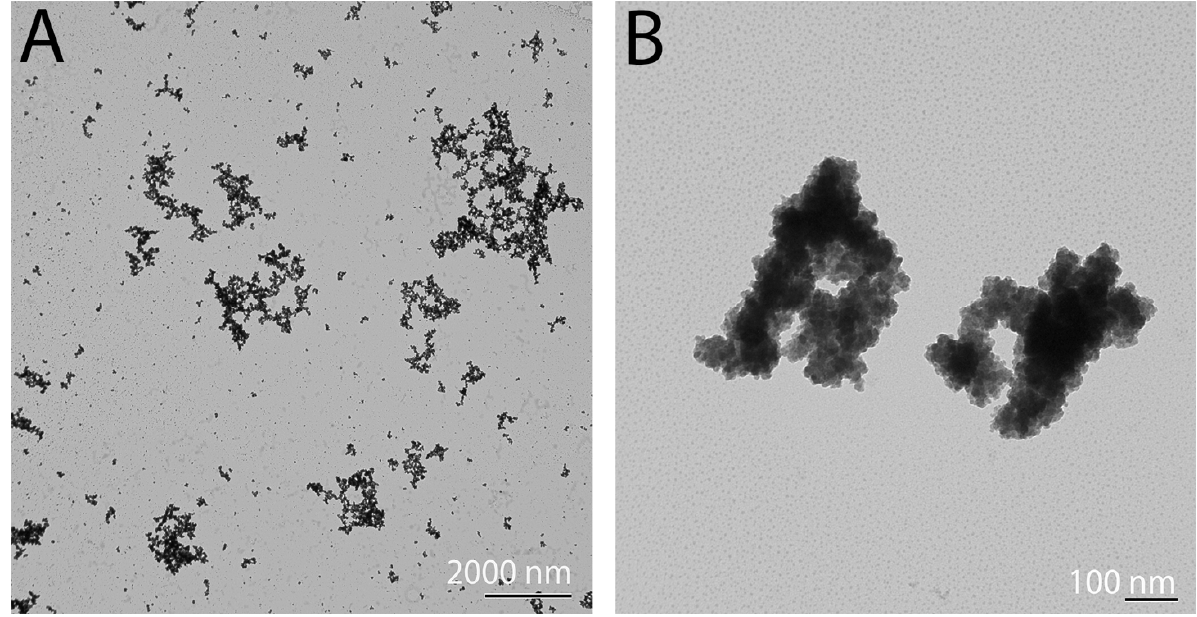
Figure A2. Transmission electron microscopy (TEM) characterization of 60 days old AV-TeNPs at low ( A ) ad high ( B ) magnification.